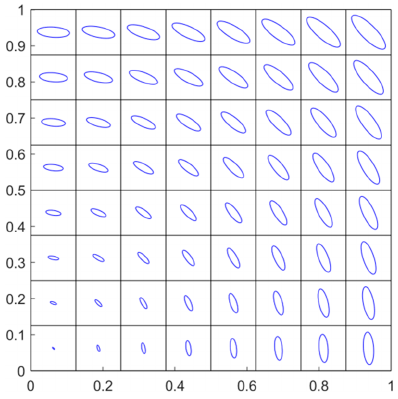
Figure 9. Rotating anisotropic permeability tensor field.